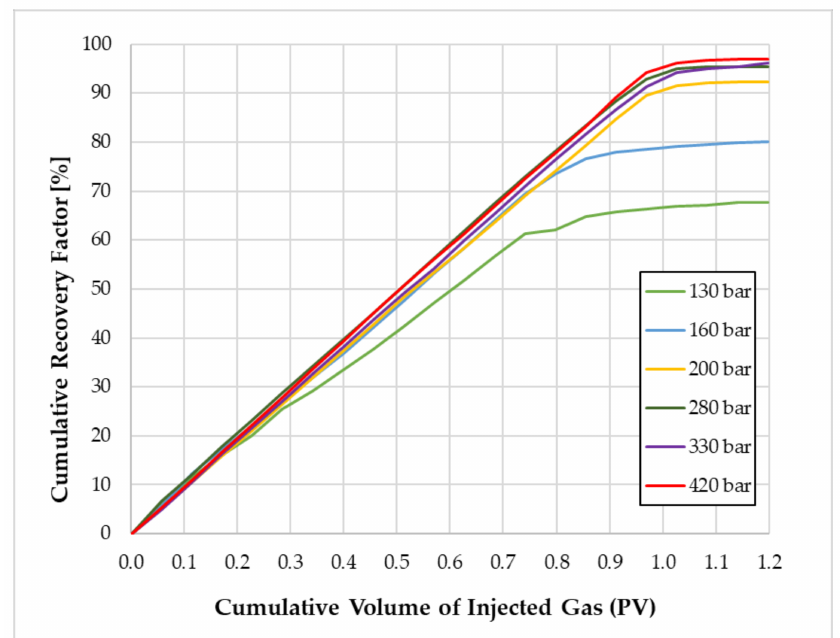
Figure 6. Overview of slim tube recovery factor curves for live oil and CO 2 injected.